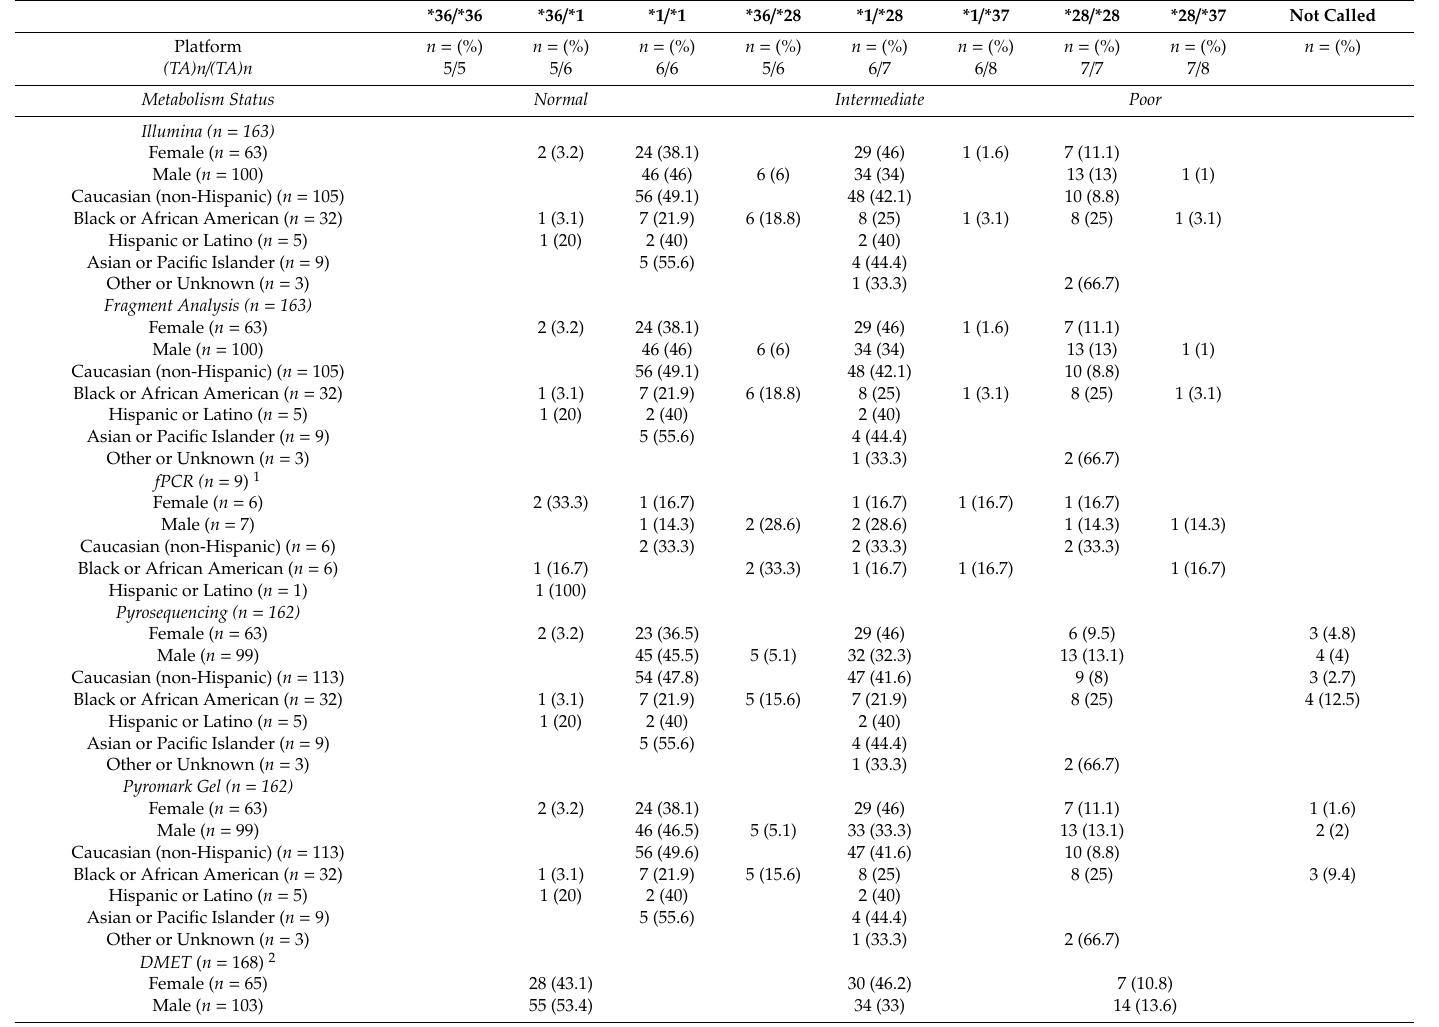
Table 2. Population by genotype frequency using di ff erent genotyping